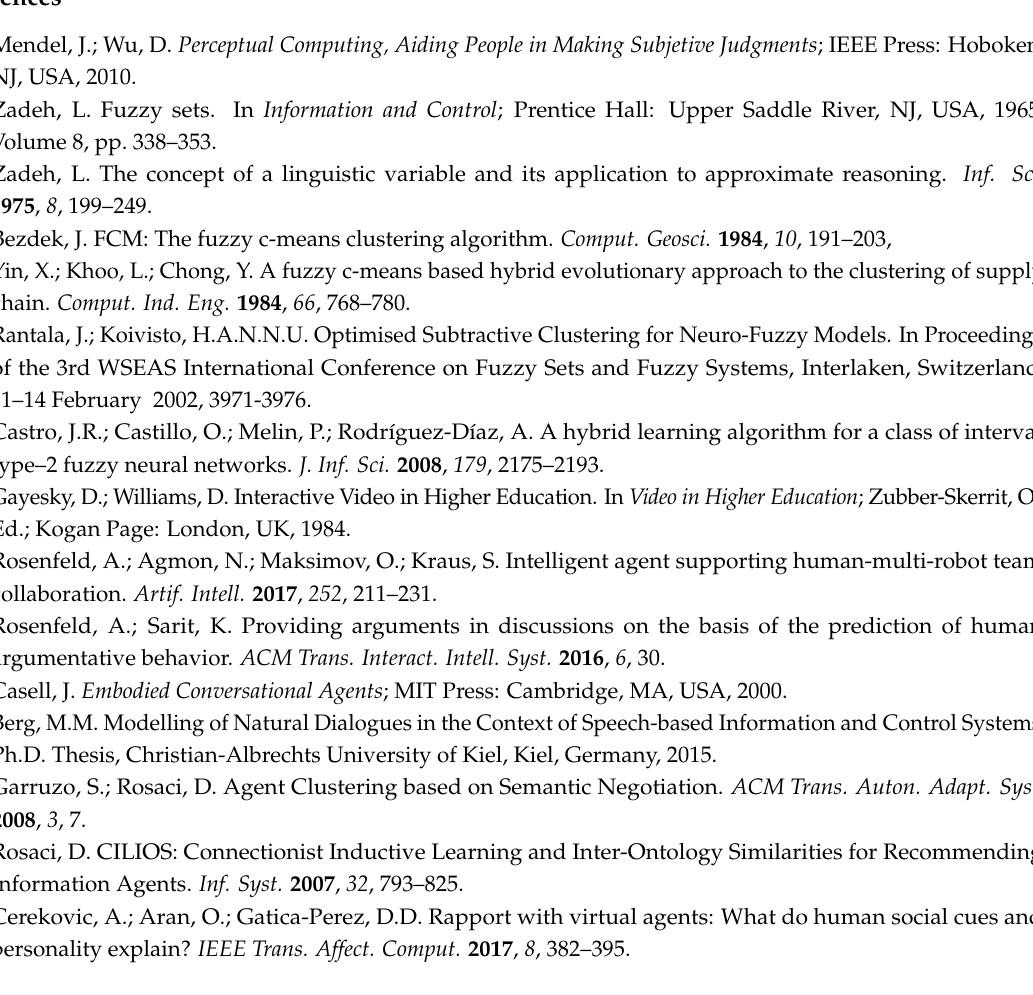
Table S1: Inputs configuration of the empirical FIS. s = standard deviation, m = average; Table S2. Outputs configuration of the empirical FIS. s = standard deviation, m = average; Table S3. Inference Fuzzy Rules of the Empirical FIS; Table S4. Inputs configuration of the Data Mined Type-1 FIS. s = standard deviation, m = average; Table S5. Outputs configuration of the Data Mined Type-1 FIS. s = standard deviation, m = average; Table S6. Rules configuration of the Data Mined Type-1 FIS; Table S7. Inputs configuration of the Neuro-Fuzzy FIS. s = standard deviation, m = average; Table S8. Outputs configuration of the Neuro-Fuzzy FIS. s = standard deviation, m = average; Table S9. Rules configuration of the Neuro-Fuzzy